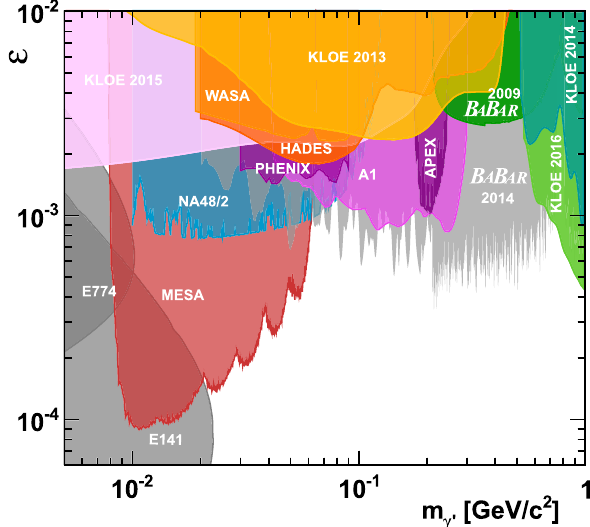
Fig. 46 MAGIX projected exclusion limits for (cid:7) as function of the dark photon mass for the γ (cid:4) → e + e − decay